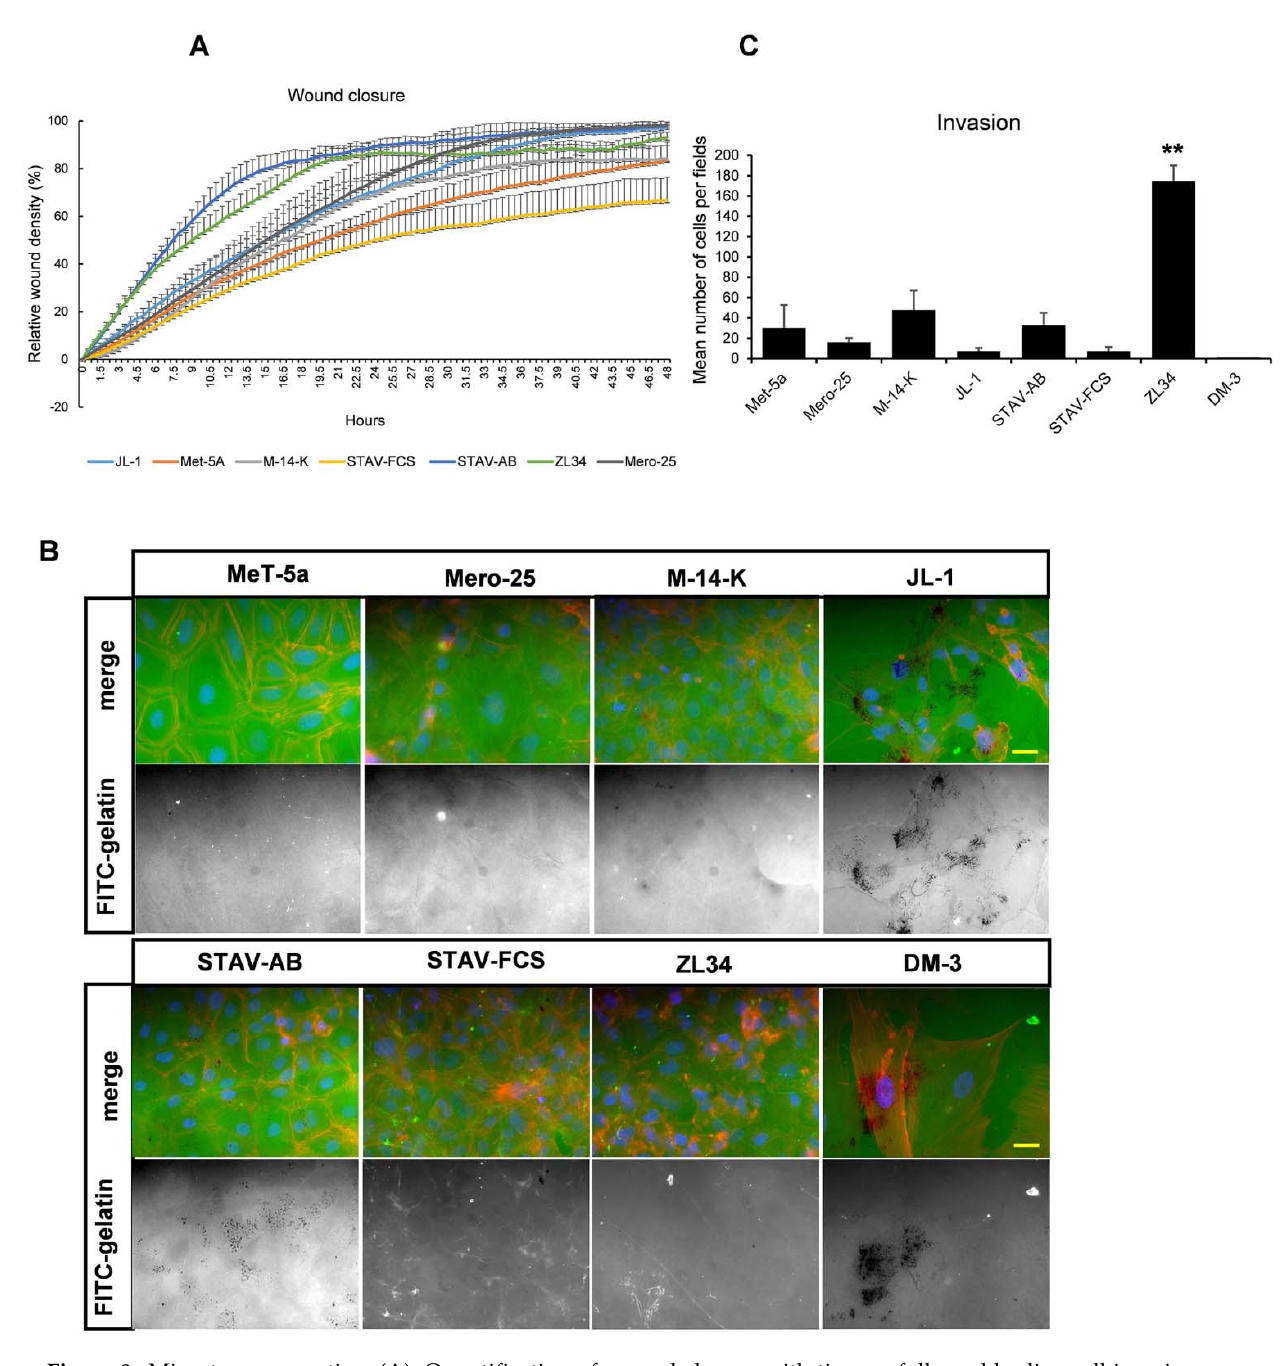
Figure 8. Migratory properties. ( A ). Quantification of wound closure with time as followed by live-cell imaging over 48 h using an IncuCyte imaging device. ( B ). Representative images of matrix degradation activity of MM cell lines 48 h after seeding on coverslips coated with FITC-labelled gelatin. Scale bar, 20 µm. ( C ). Quantification of the migration of STAV-FCS, STAV-AB, and ZL34 cells through Boyden-type filter chambers coated with Matrigel, in terms of invasion index. Unpaired two-way Student’s t -tests with unequal variance were performed to calculate statistical significance for the data. ** = p < 0.01 marks the statistical significant difference compared to MeT-5a.